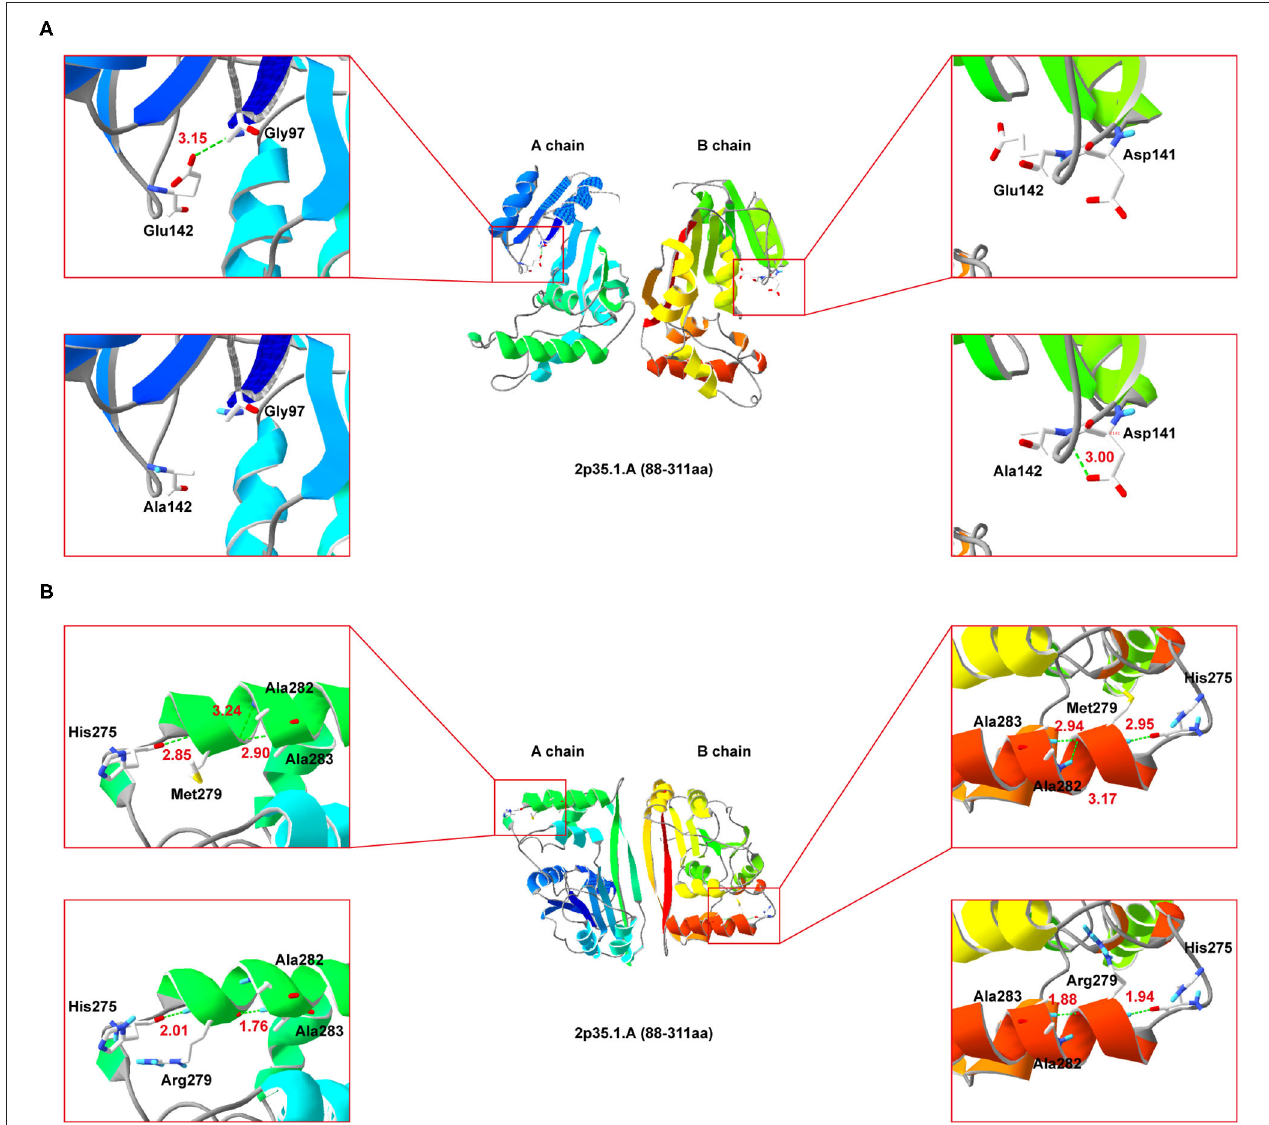
FIGURE 4 | Secondary-structure of NDUFAF5 (residues 88–311) is shown. The intermediate region of (A,B) present a full picture of the structure of the protein dimer. Top left and top right of the (A,B) show magnified view of the outlined region containing the conserved residues. Lower left and lower right of (A,B) show magnified view of the outlined region containing the mutant